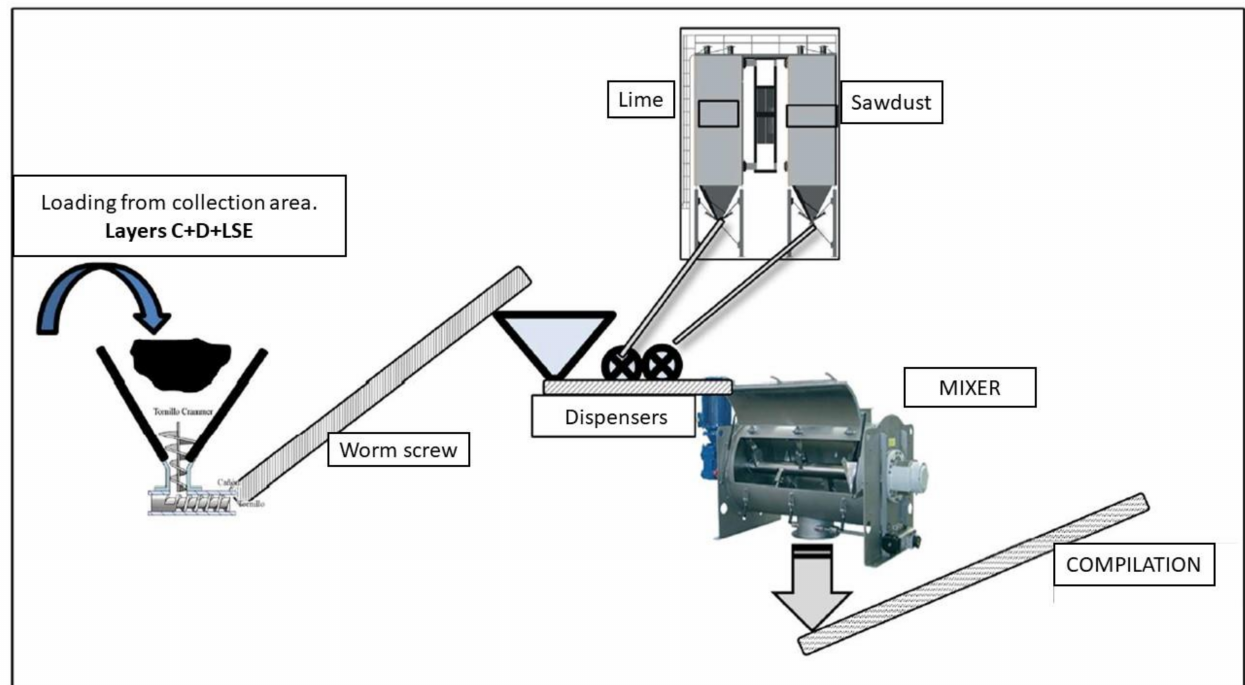
Figure 3. Treatment of the waste.